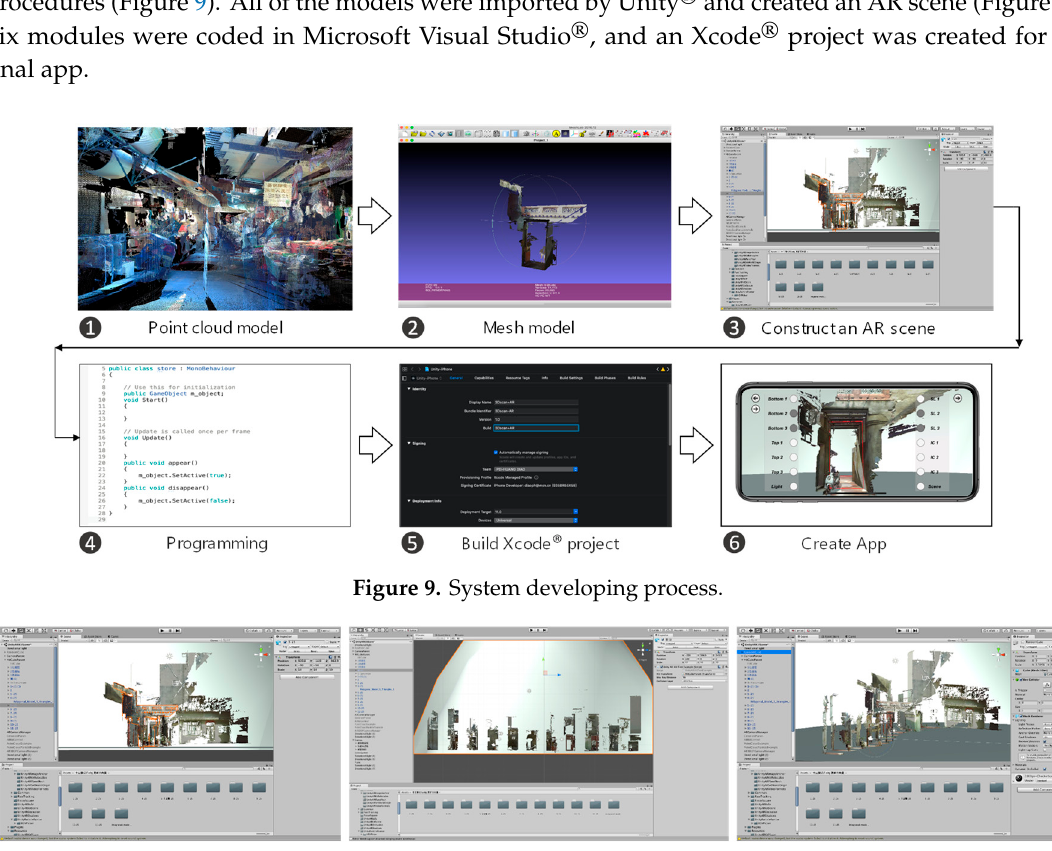
Figure 10. Unity operation interfaces (as shown in 11 slices of the section).